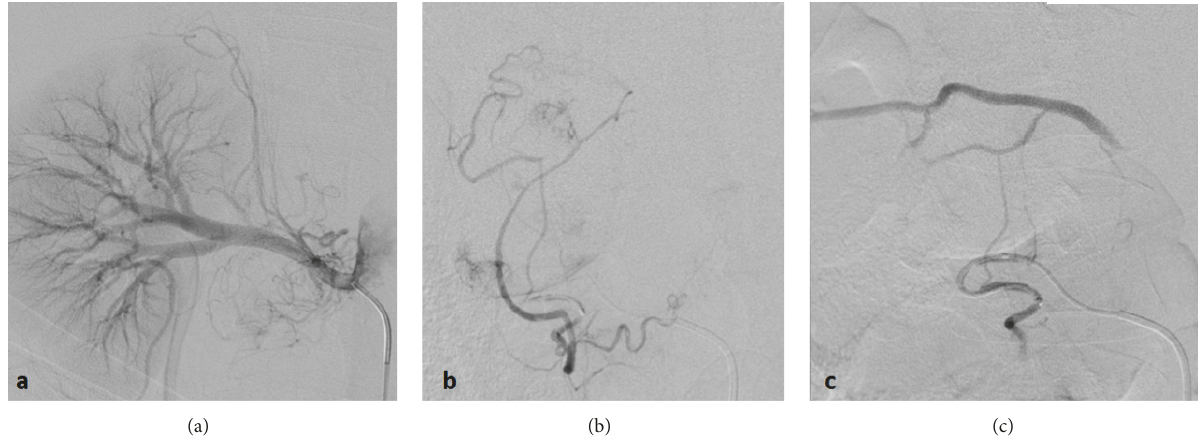
Figure 2: Angiography showing several feeding arteries arising from the right renal artery (a) and the 3rd right lumbar artery (L3) (b). Successful embolization of several arterial arteries: e.g., the 3rd right lumbar artery (c).